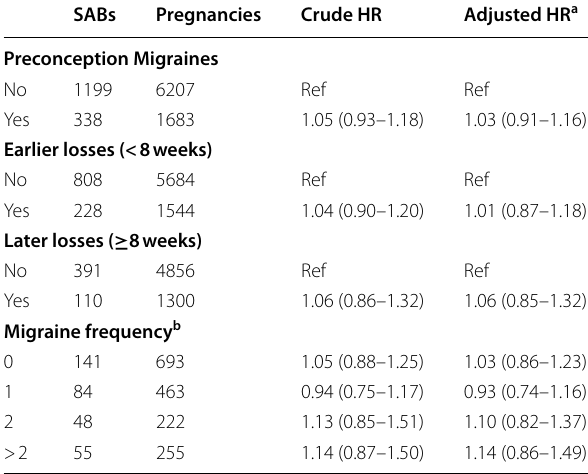
Table 2 Association between migraine and spontaneous abortion ( n 7890) =